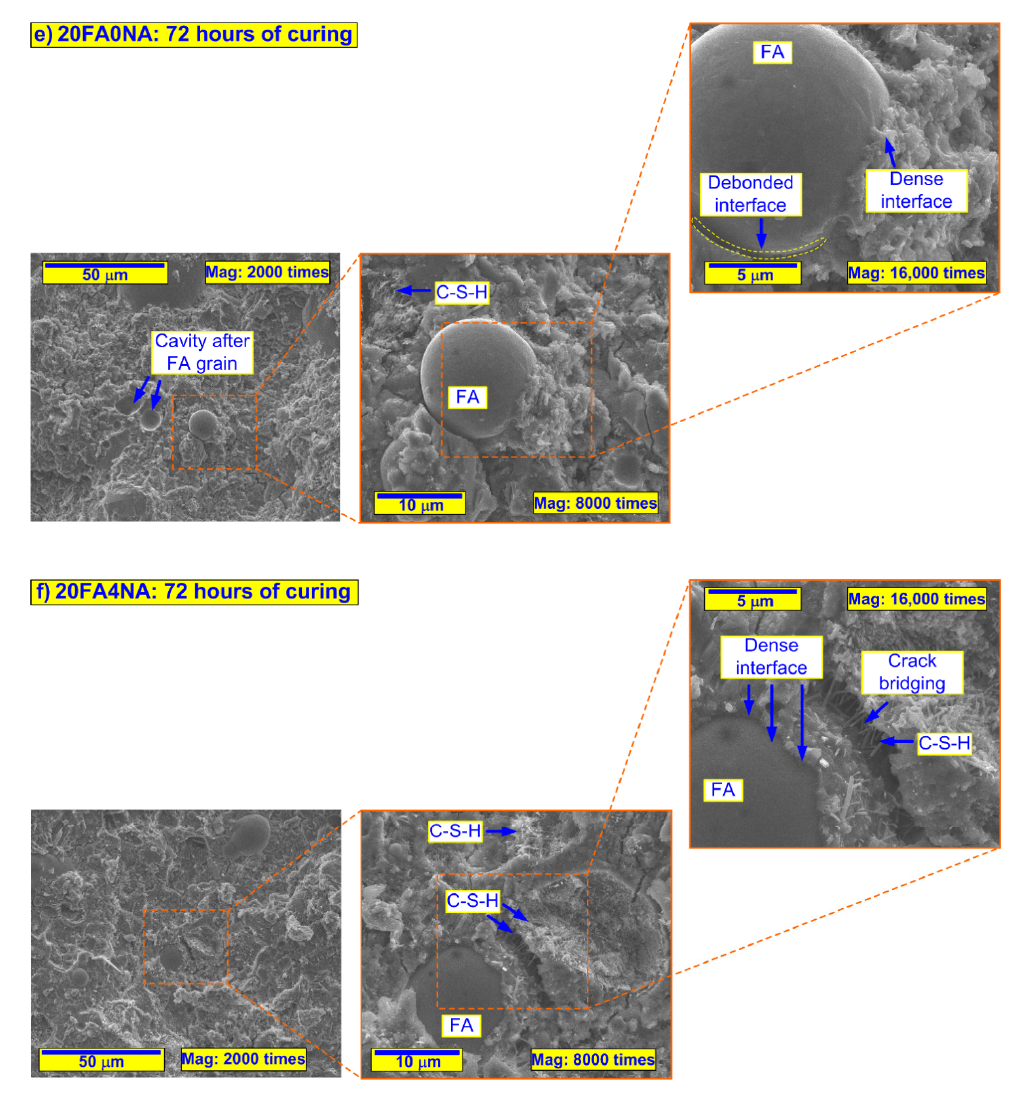
Figure 5. SEM micrographs of analyzed composites including FA in selected significant periods of curing: ( a ) 0FA0NA—12 h of curing, ( b ) 20FA4NA—12 h of curing, ( c ) 0FA0NA—24 h of curing, ( d ) 20FA4NA—24 h of curing, ( e ) 0FA0NA—72 h of curing, ( f ) 20FA4NA—72 h of curing.